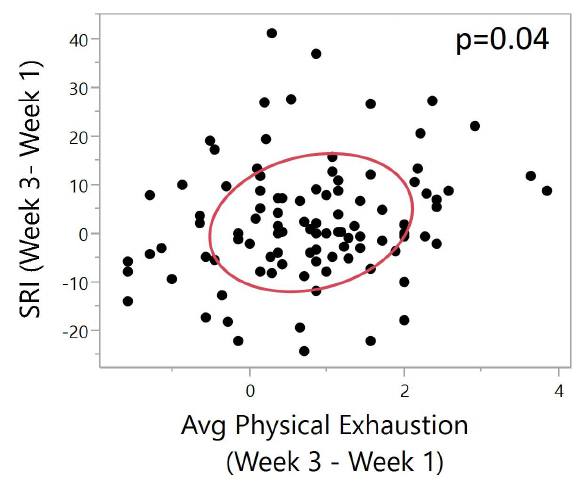
Figure 5. Bivariate plot of SRI (Week 3–Week 1) vs. physical exhaustion (Week 3–Week 1). The red ellipse shows a graphical indicator of the correlation between two di ff erences. The red ellipsoid collapses diagonally as the correlation between them approaches either 1 or − 1. The ellipsoid is more of a circle and less of a diagonal if the two variables are less correlated. The ellipse is encircling 50% of the points on the plot. Significant positive correlation between SRI di ff erence and physical exhaustion di ff erence (Pearson, N = 99, ρ = 0.20, p = 0.04). A higher SRI di ff erence indicates improved sleep regularity between week 3 and week 1. A higher physical exhaustion di ff erence indicates decreased exhaustion between week 3 and week 1. Significant correlation shows that with increased sleep regularity, there is a lower average physical exhaustion between the two time